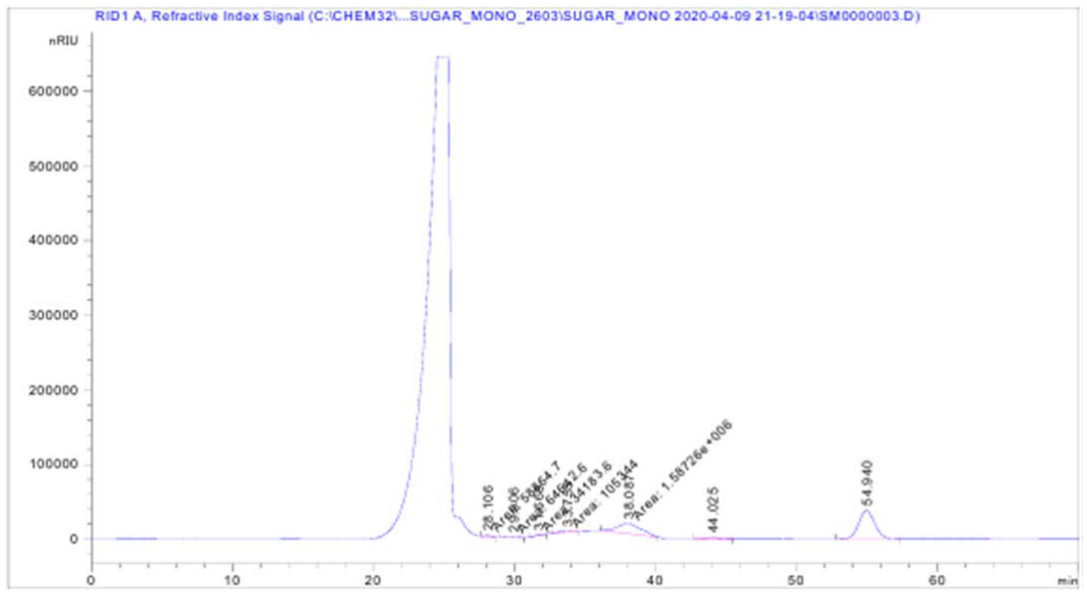
Fig. 2. Chromatogram of WSPC from Pimpinella anisum herbs